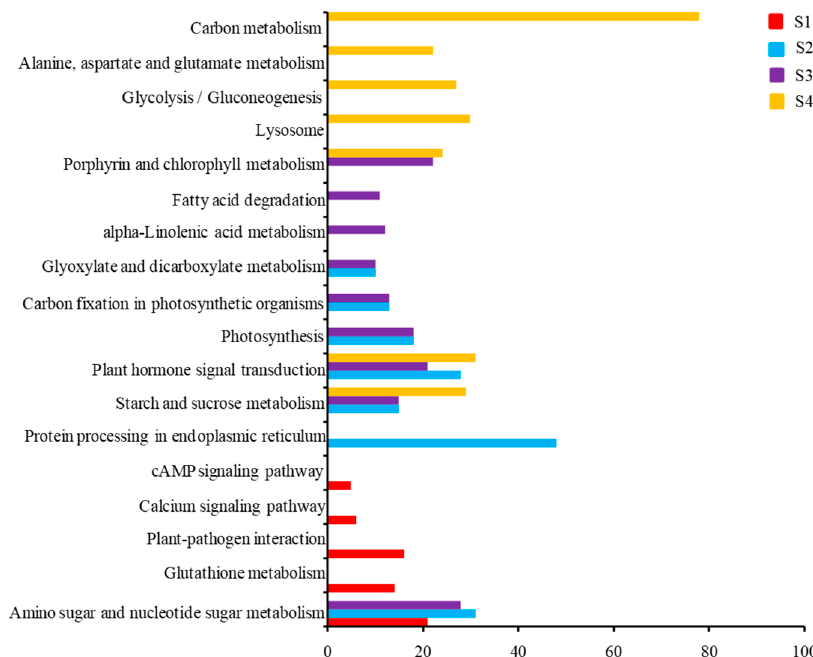
Figure 5. Kyoto Encyclopedia of Genes and Genomes (KEGG) analysis of DEGs between WT and m68 in different leaf senescence stages. The X -axis indicates the number of genes belonging to the KEGG pathway on the left side. The DEGs in S1, S2, S3, and S4 are shown in red, blue, purple, and yellow , respectively.